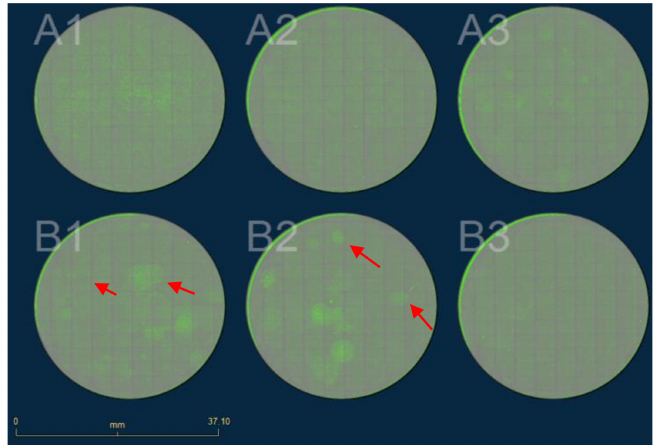
Figure 9. eGFP fluorescence image of polyclonal cells after transfer into 6-well plate with serial dilution. The polyclonal cells are marked by a red arrow. Scale bar = 3.71 cm. Different polyclonal cells are marked by the red arrow.